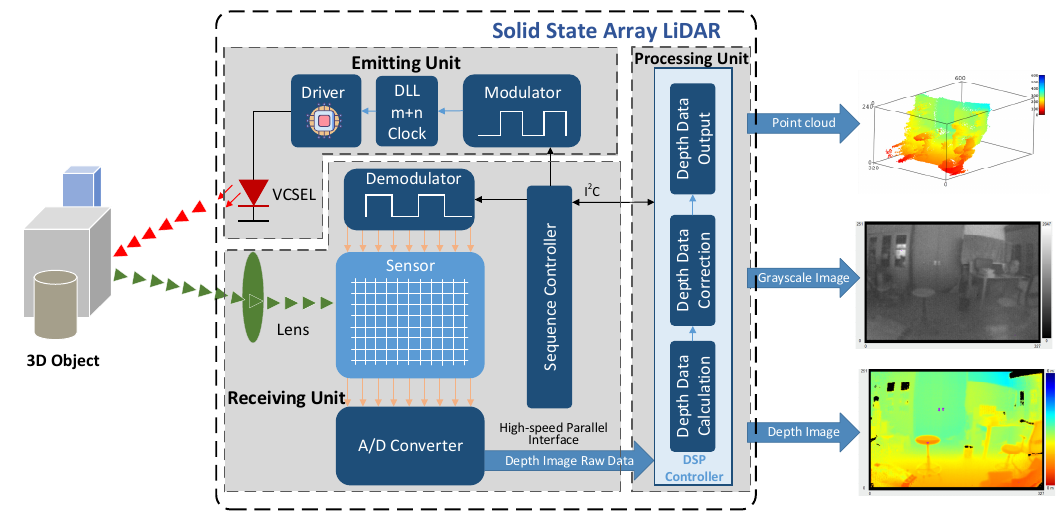
Figure 1. The fundamental principle of the photonic mixer device (PMD) solid-state array Lidar.